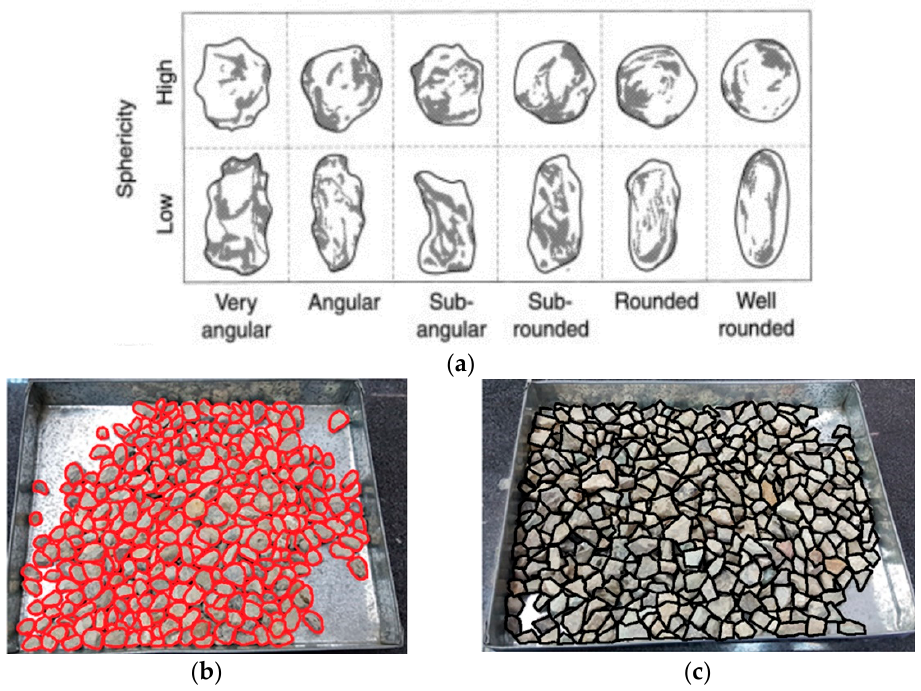
Figure 1. Different geometries of aggregates: ( a ) general classification [25]; ( b ) rounded aggregates used in the present research; ( c ) angular aggregates used in the present research.